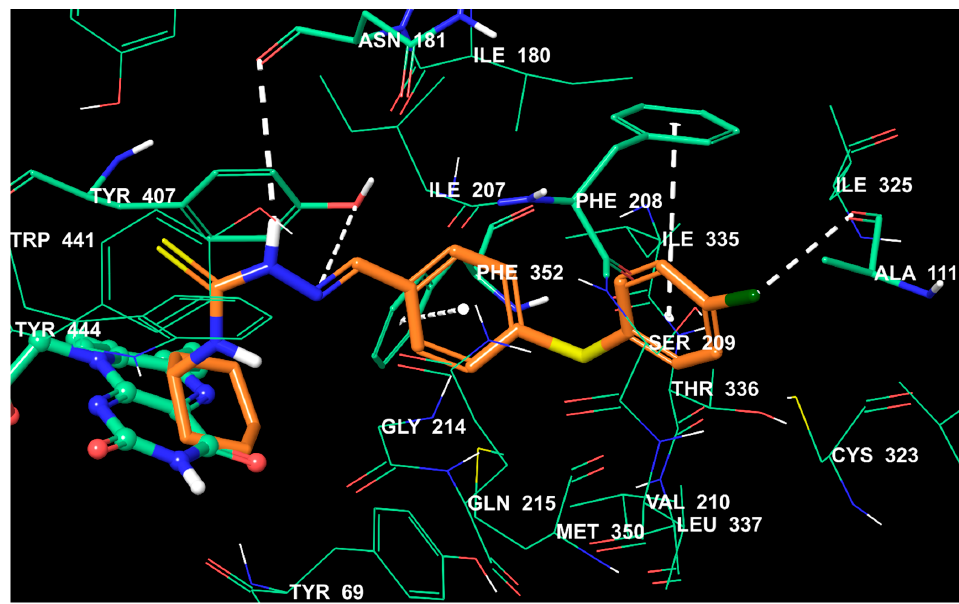
Figure 3. The interacting mode of compound B24 in the active region of MAO-A. The inhibitor and the important residues in the active site of the enzyme are presented by tube model. The flavin adenine dinucleotide (FAD) molecule is colored green with ball and stick model. After superposing X-ray ligands Root Mean Square Deviation (RMSD) value is 0.029 Å. Docking score, glide gscore and glide emodel for compound B24 were found as: − 11.869, − 11.869 and − 96.645, respectively.